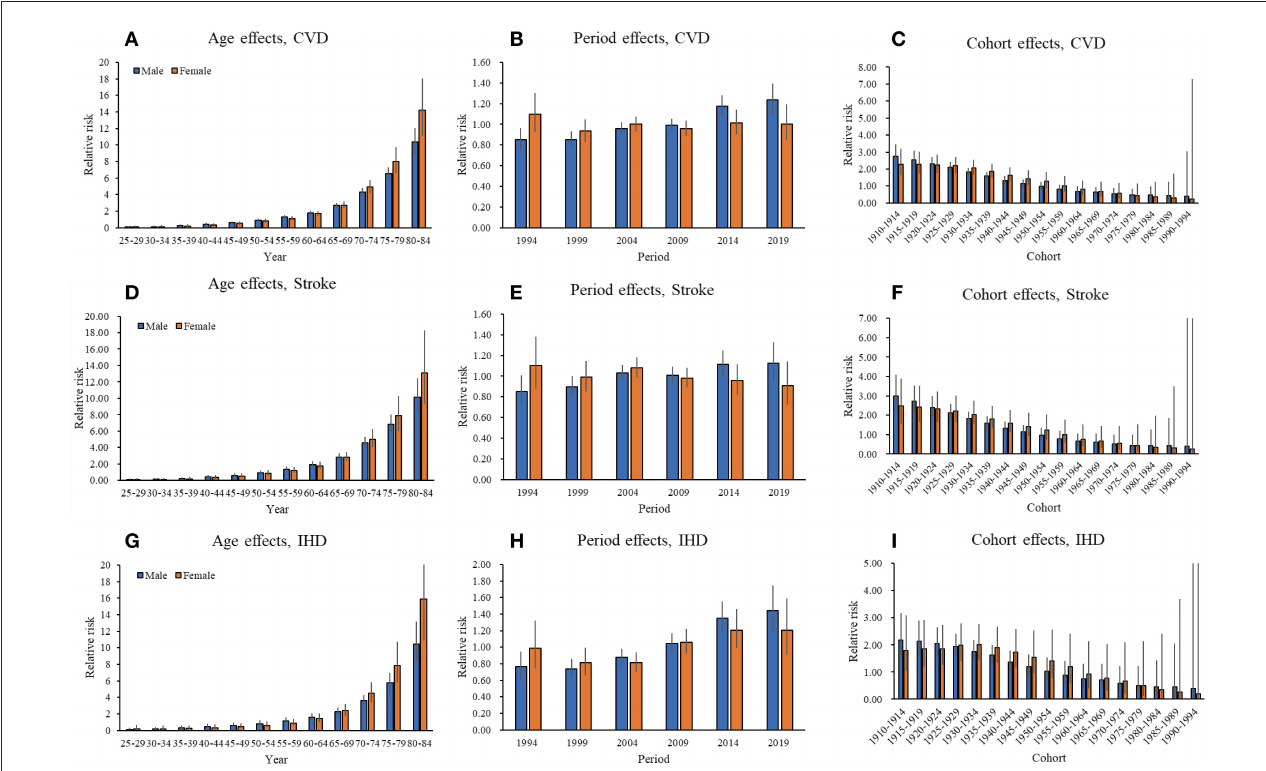
FIGURE4 Parameter estimates of age, period, and cohort effects on CVD, stroke, and IHD mortality attributable to non-optimal temperatures from 1990 to 2019. (A , D , G) Age relative risk of CVD, stroke, and IHD mortality attributable to non-optimal temperatures and the corresponding 95% CI. (B , E , H) Period relative risks of CVD, stroke, and IHD mortality attributable to non-optimal temperatures and the corresponding 95% CI. The period relative risk was adjusted for age and nonlinear cohort effects. (C , F , I) Cohort relative risks of CVD, stroke, and IHD mortality attributable to non-optimal temperatures and the corresponding 95% CI. The cohort relative risk was adjusted for age and nonlinear period